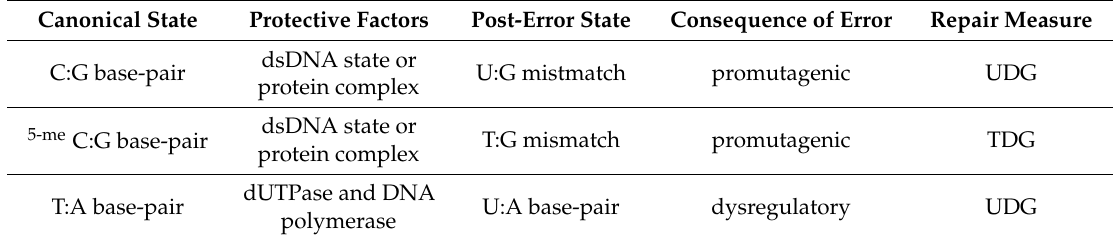
Table 2. Perturbation of DNA fidelity and cellular regulation by pyrimidine deamination